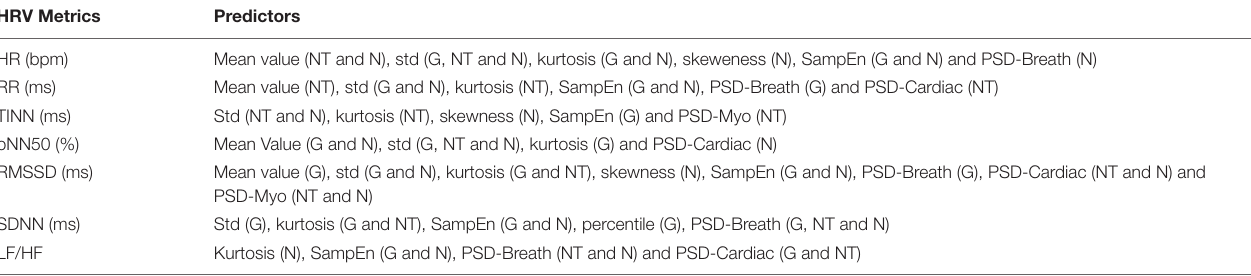
TABLE 2 | Thermal features extracted from each ROI selected to feed the different SVR models used to estimate the HRV indices considered. HRV Metrics